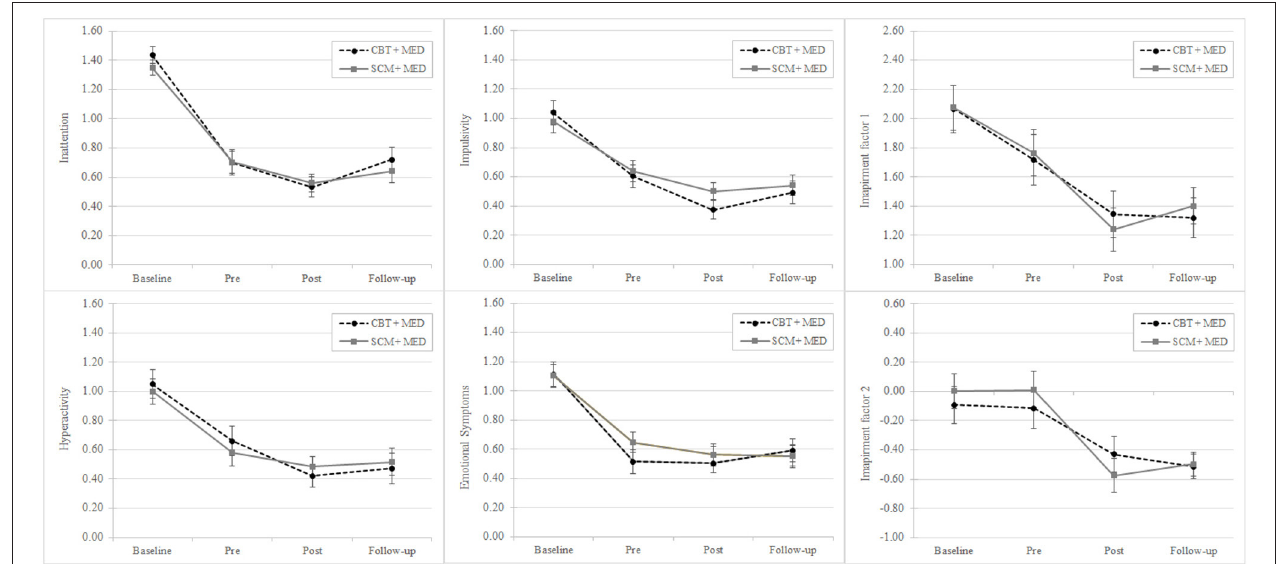
FIGURE 3 | Mean of latent variables: ADHD symptoms (inattention, hyperactivity, impulsivity, and emotional symptoms) and impairments changes over time (baseline, pre, post, and follow-up evaluation). CBT, Cognitive-behavioral therapy; SCM, Standard clinical management; MED, Medication.